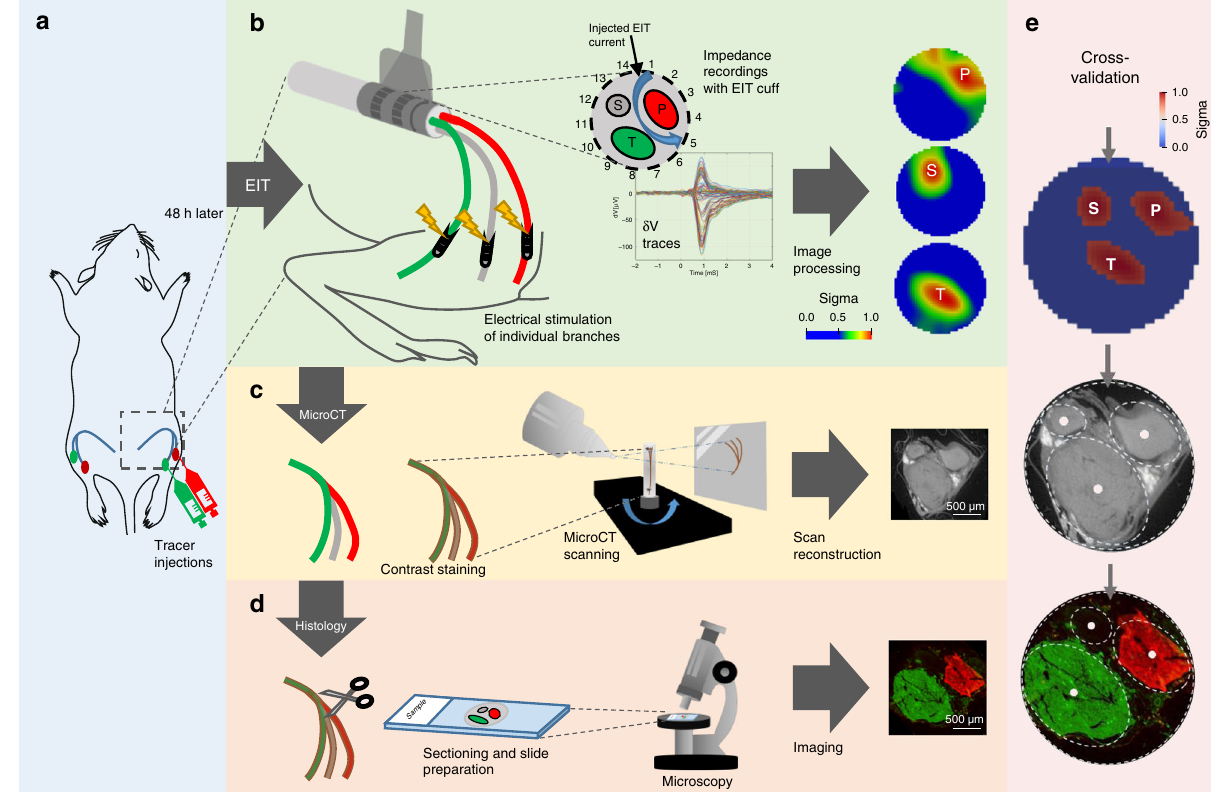
Fig. 1 Experimental design. a Neural tracers were injected into the peroneal and tibial fascicles of the rat sciatic nerve 48 h before the EIT experiment. b EIT recordings and image reconstruction. Left: peroneal (red), tibial (green), and sural (gray) fascicles were electrically stimulated with bipolar electrodes placed 1 – 1.5 cm distally from the EIT cuff. Middle: diagram showing the 4-off electrode spacing con fi guration in the 14-electrode cuff forming a full ring around the rat common sciatic nerve; example of multiple δ V traces from an experimental EIT recording. Right: Exemplar cross-sectional localization of the recorded fascicular activity from tibial (T), peroneal (P), and sural (S) fascicles at the level of the common sciatic nerve. The range of values for every image was normalized between 0 and 1 and the rainbow color scale indicates the top 50% of color for each image, i.e., full width at half maximum (FWHM) intensity scaling. c After the EIT experiment, the nerve was scanned with microCT. d Fluorescent microscopy of histological sections. In this exemplar section, tibial fascicle is labeled with fl uorescent Dextran-Alexa 488 (green) and peroneal fascicle with Dextran-Alexa 555 (red); sural fascicle is not labeled. e Cross-validation of EIT images of impedance changes in individual fascicles against microCT and histological sections.